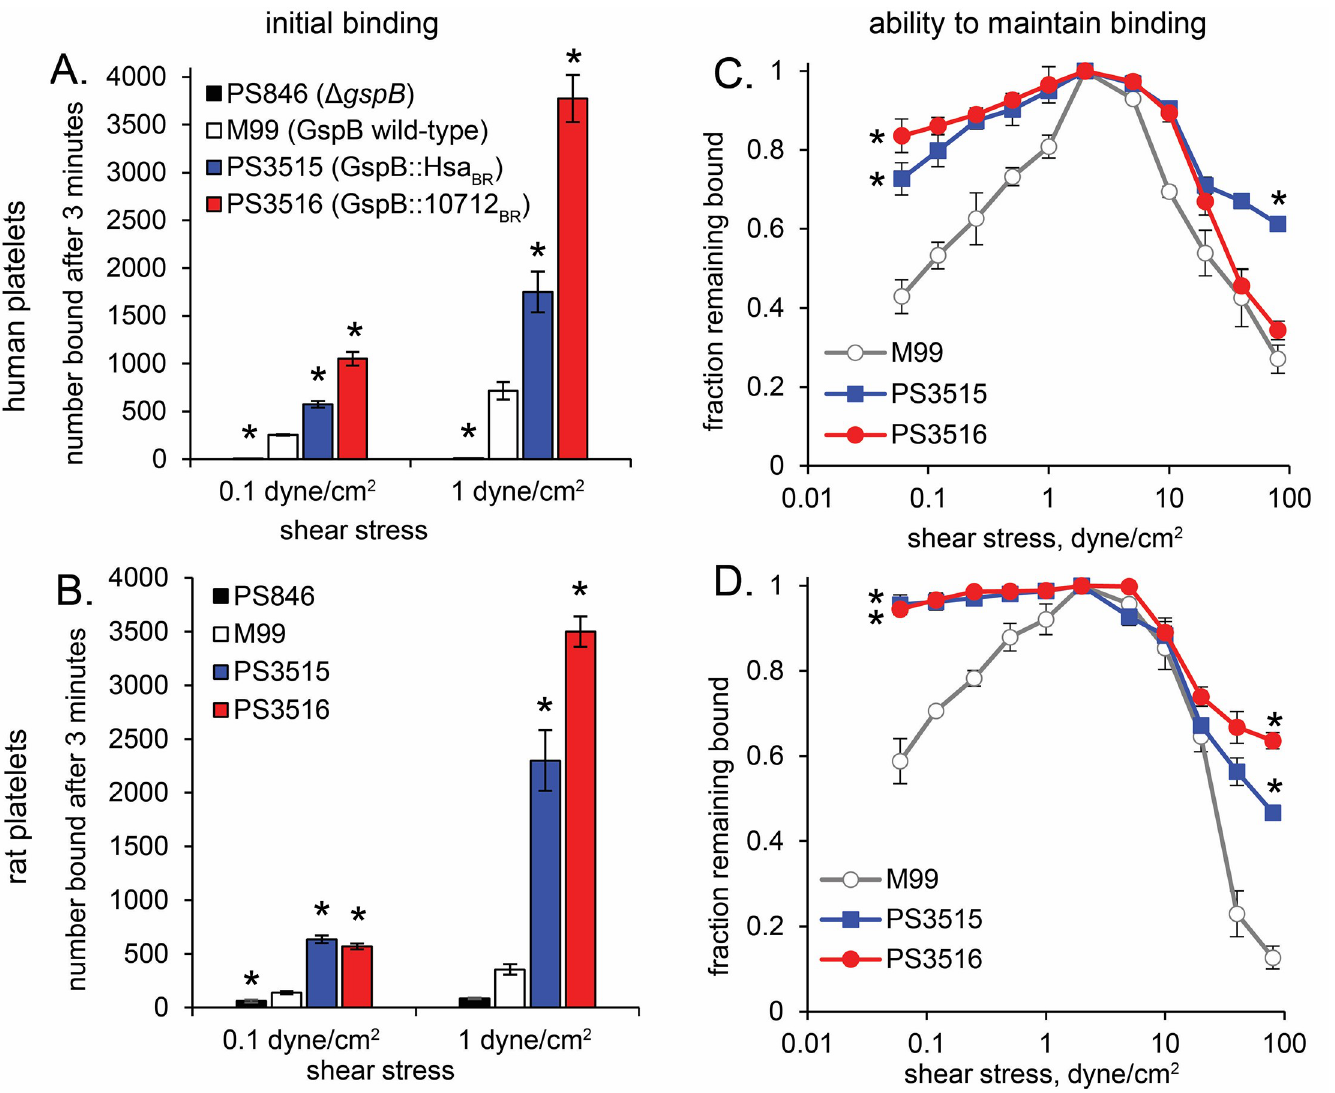
Fig 7. Binding of S . gordonii M99 and the isogenic variant strains to immobilized human or rat platelets under shear. The gspB deletion strain PS846 has previously been used to assess GspB-dependent binding and virulence [15, 26, 30, 36, 49]. Suspensions of bacteria were washed through microfluidic chambers containing immobilized human (A) or rat (B) platelets, at flow rates corresponding to the indicated shear stresses, and adherent bacteria recorded using videomicroscopy and counted. To measure detachment from human (C) or rat (D) platelets, bacteria that initially bound at 1 dyne/cm 2 were subjected to stepwise lower or higher flow rates, and the fraction of bacteria remaining bound at the indicated shear stresses were counted. Asterisks indicate p < 0.05 compared with M99.